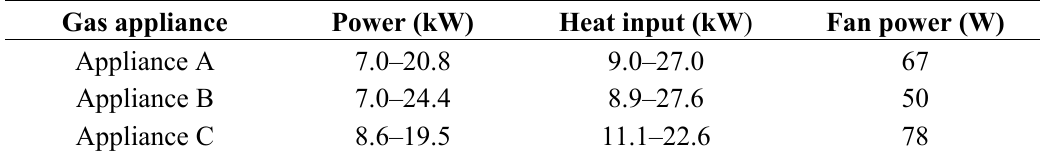
Table 1. Characteristics of gas-fired instantaneous water heaters with combustion chamber sealed with respect to the room used for first and second stages of